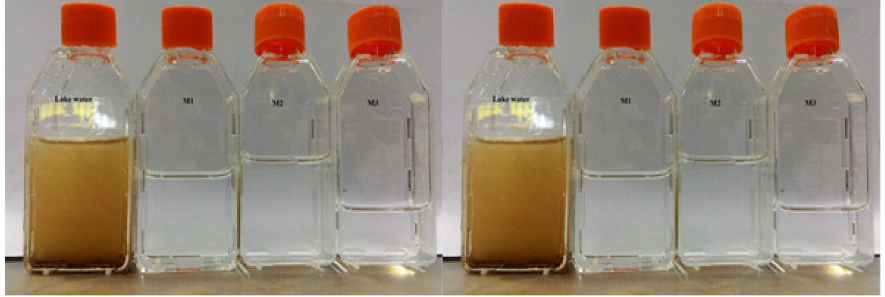
Figure 8. The visual result of change in color of lake water via non-treated and post-treated membrane after